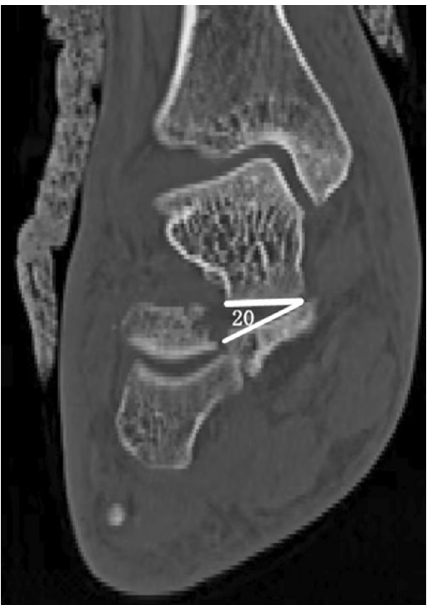
Figure 2. Coronal CT showings the angulation of the sustentaculum